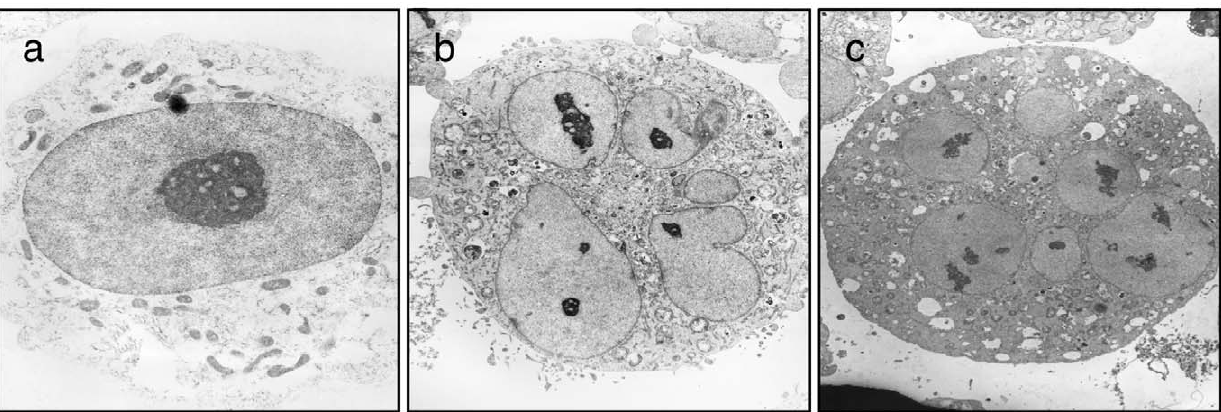
Figure 7. Q15 induces abnormal cell division. KMS34 cells were treated with DMSO (a) or 5 m M Q15 (b and c) for 24 h, then observed with an electron microscope. Micronuclei can be seen in Q15-treated